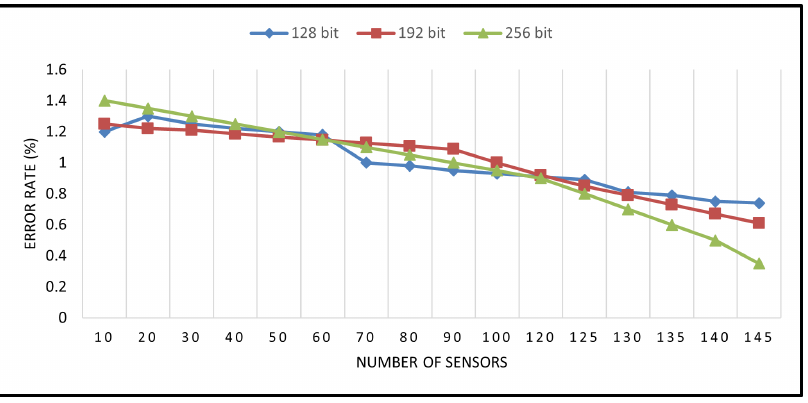
Figure 9. Error estimation percentage on the data received by the